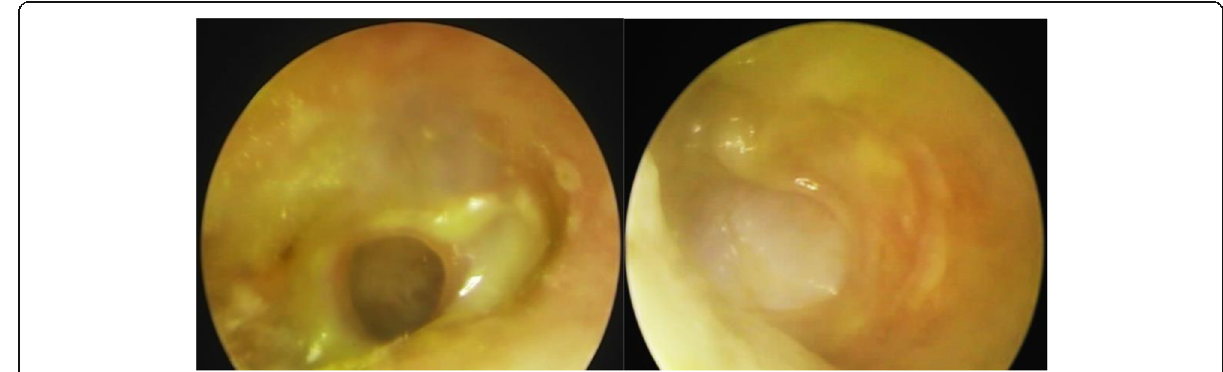
Fig. 2 Preoperative and postoperative endoscopic examination of a successful case of fascia